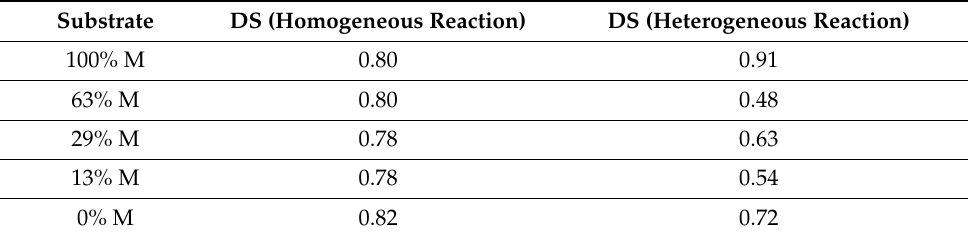
Table 3. DS value as a function of the alginate structure and acetylation reaction